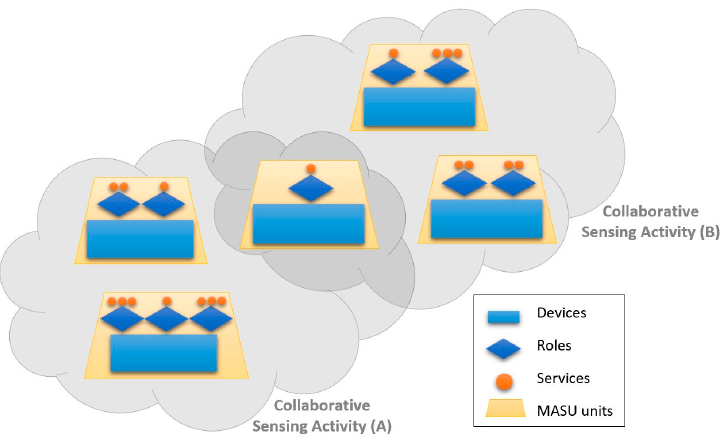
Figure 1. Overview of the MASU work scenario.